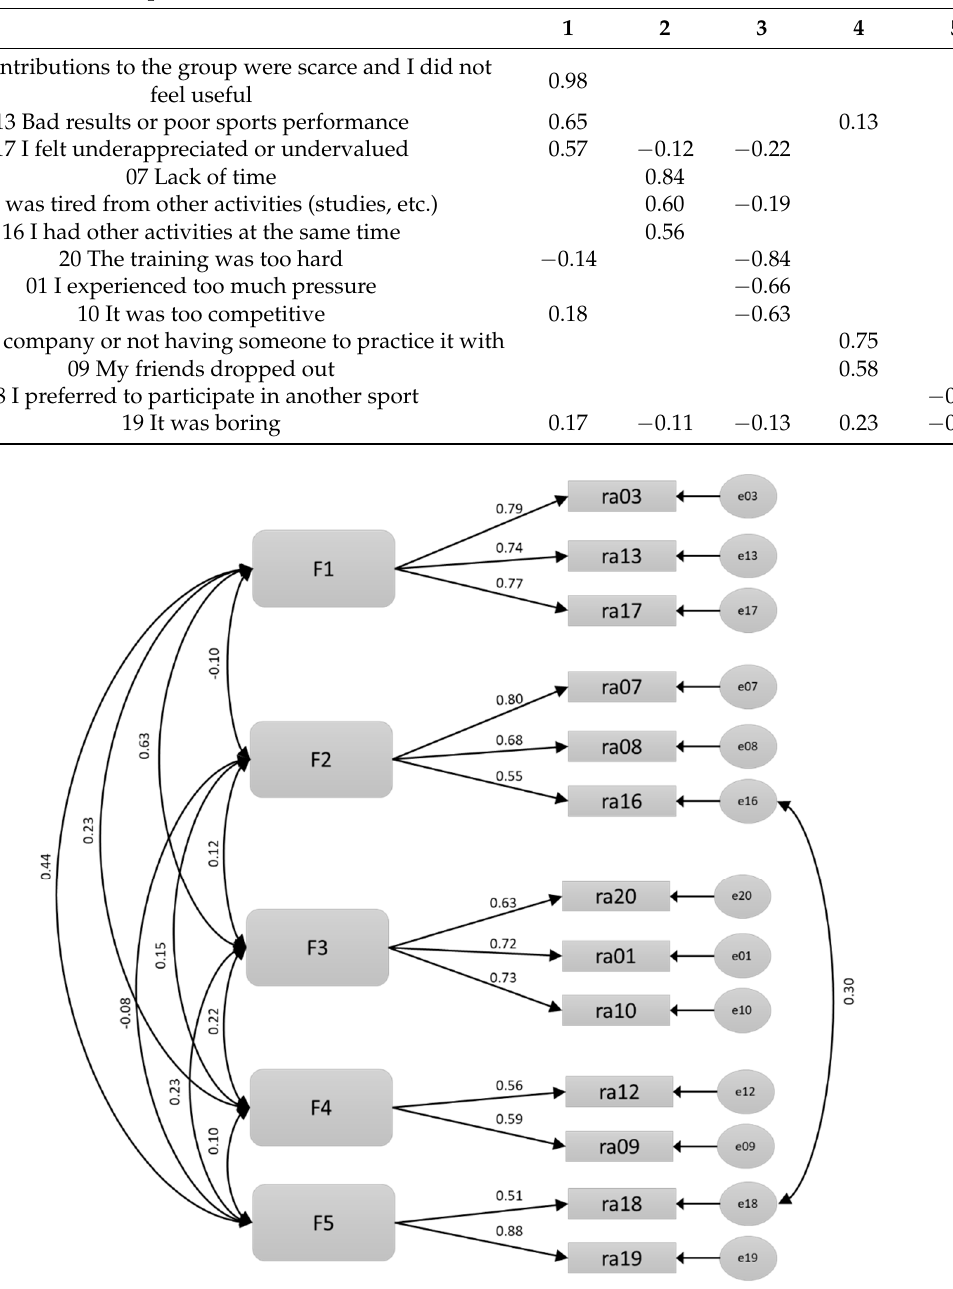
Figure 1. Measurement model of the scale of reasons for dropping out of sports. The main difference between the genders is seen in Factor 5, lack of enjoyment, which includes dropping out due to preferring another sports activity; a moderately higher score is seen with men (d = 0.054). Four factors were found with statistically significant but small differences, but men indicate the factors of bad sports performance and lack of company more, while women are more prone to identify with excessive pressure, lack of time, and